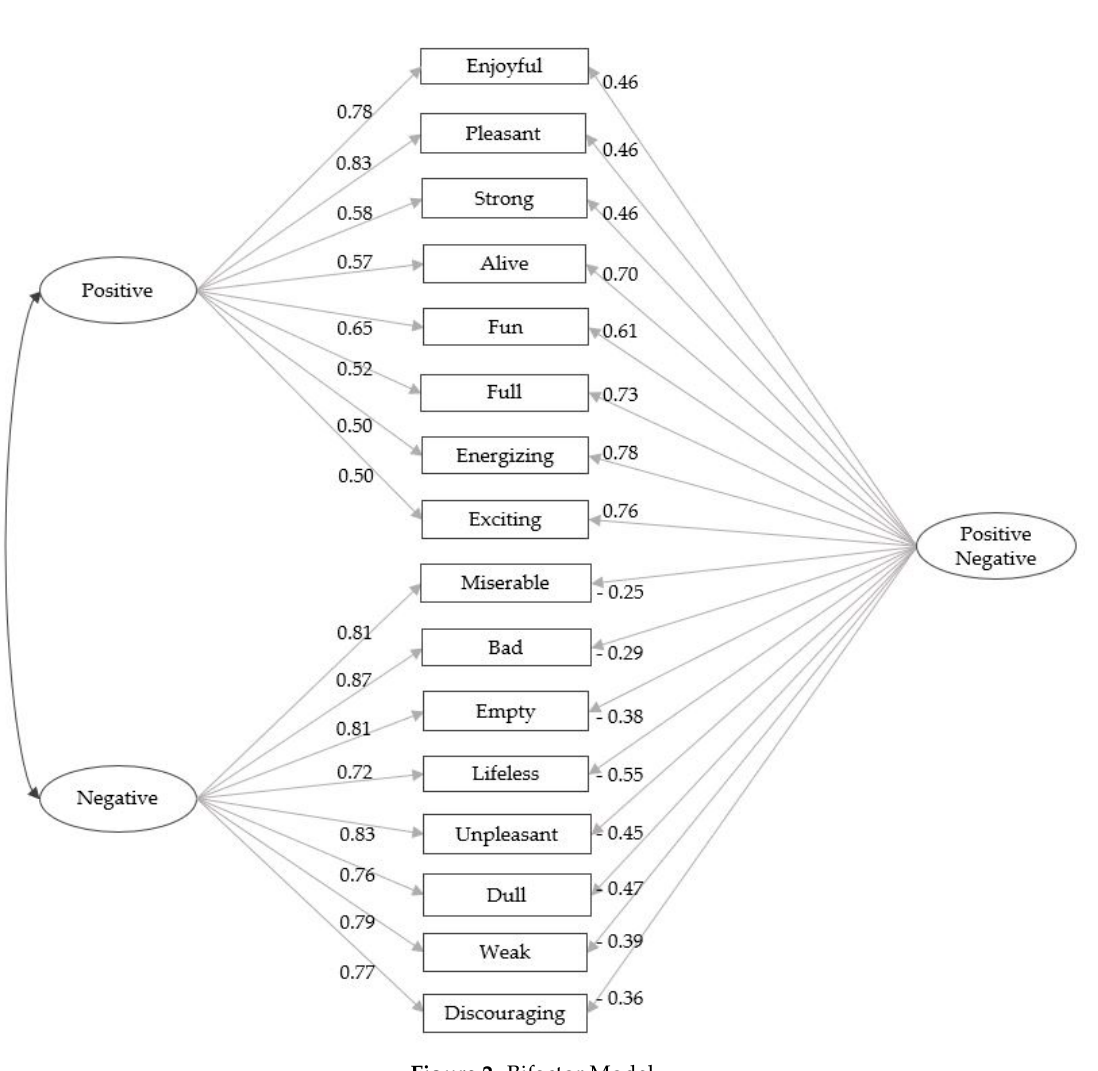
Figure 2. Bifactor Model.